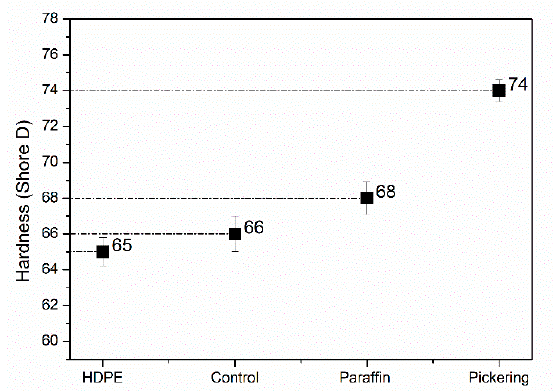
Figure 9. Hardness of HDPE and WPCs made from untreated WFs (control), paraffin emulsion treated WFs (paraffin), and Pickering emulsion treated WFs (Pickering).